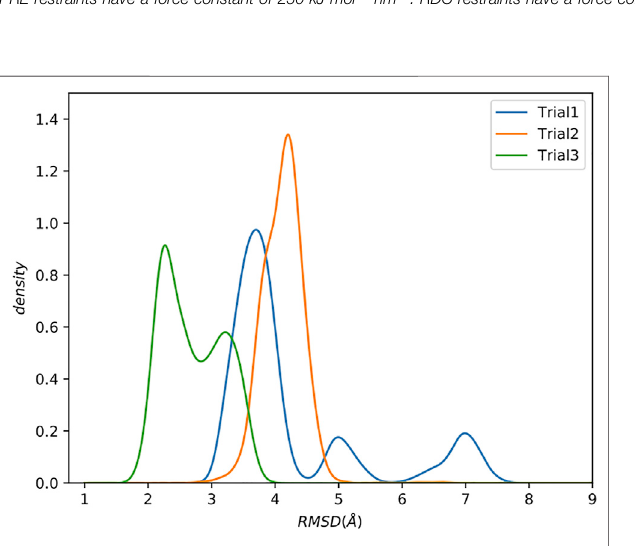
FIGURE 3 | Increasing complexity of how restraints are incorporated results in better sampling. Kernel Density Estimate (KDE) plot of backbone RMSD to the reference structure. The last 0.5 µs were analyzed. Flexible tails at the N- and C-termini of the protein were